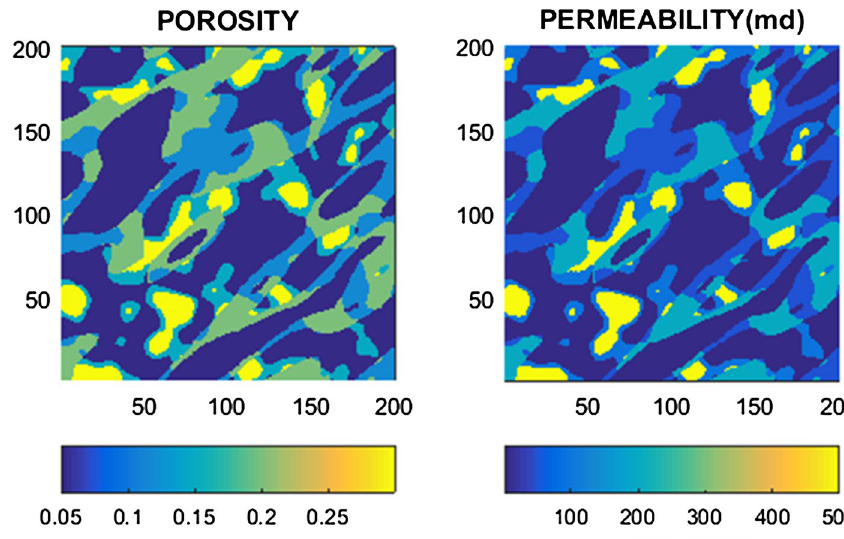
Fig. 5 Reference case—porosity and